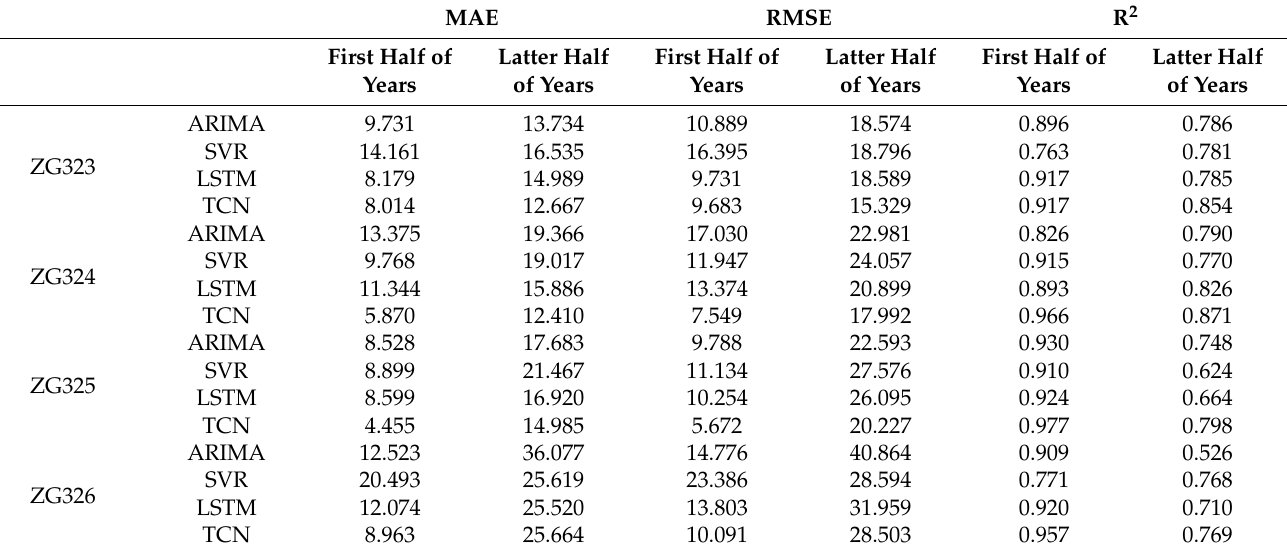
Table 8. Comparison of accuracy between the first half and latter half of the